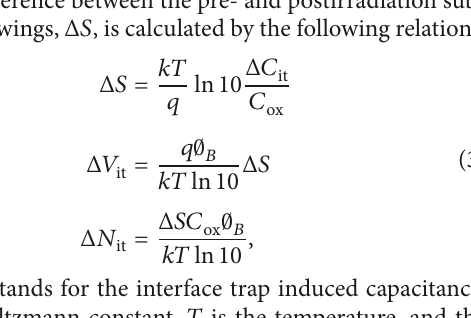
Figure 3: (a) Δ𝑉 of Si VDMOS with different gate dielectrics after different TID bias irradiation; (b) Δ𝑉 TH VDMOS with both single SiO 2 and double Si 3 N 4 /SiO 2 gate dielectrics after different TID bias